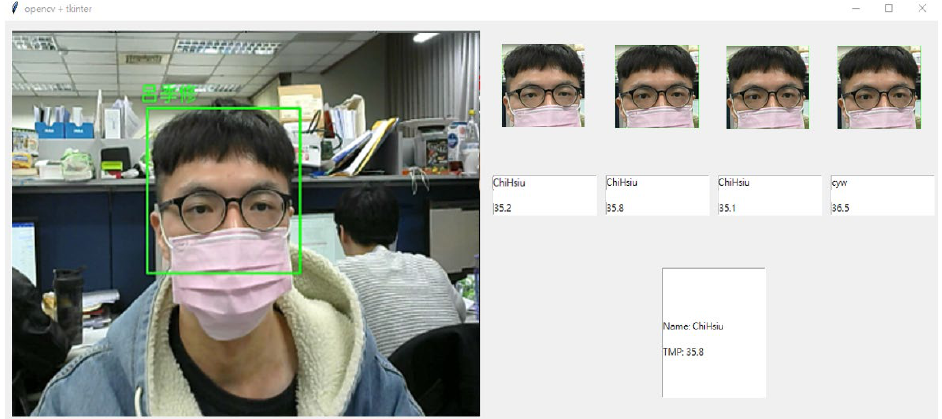
Figure 6. The diagram of our proposed face recognition attendance system. After matching with the database, the identity and temperature are recorded.